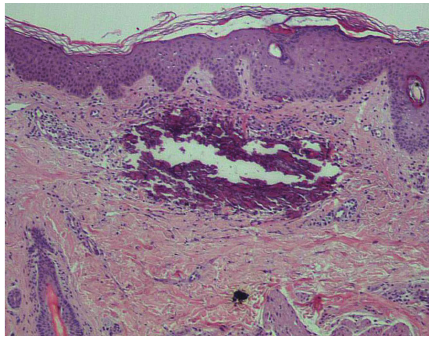
Figure 3: Hematoxylin and eosin stain reveals amorphous, basophilic deposit in reticular dermis of calcium deposits; original magnification × 100.